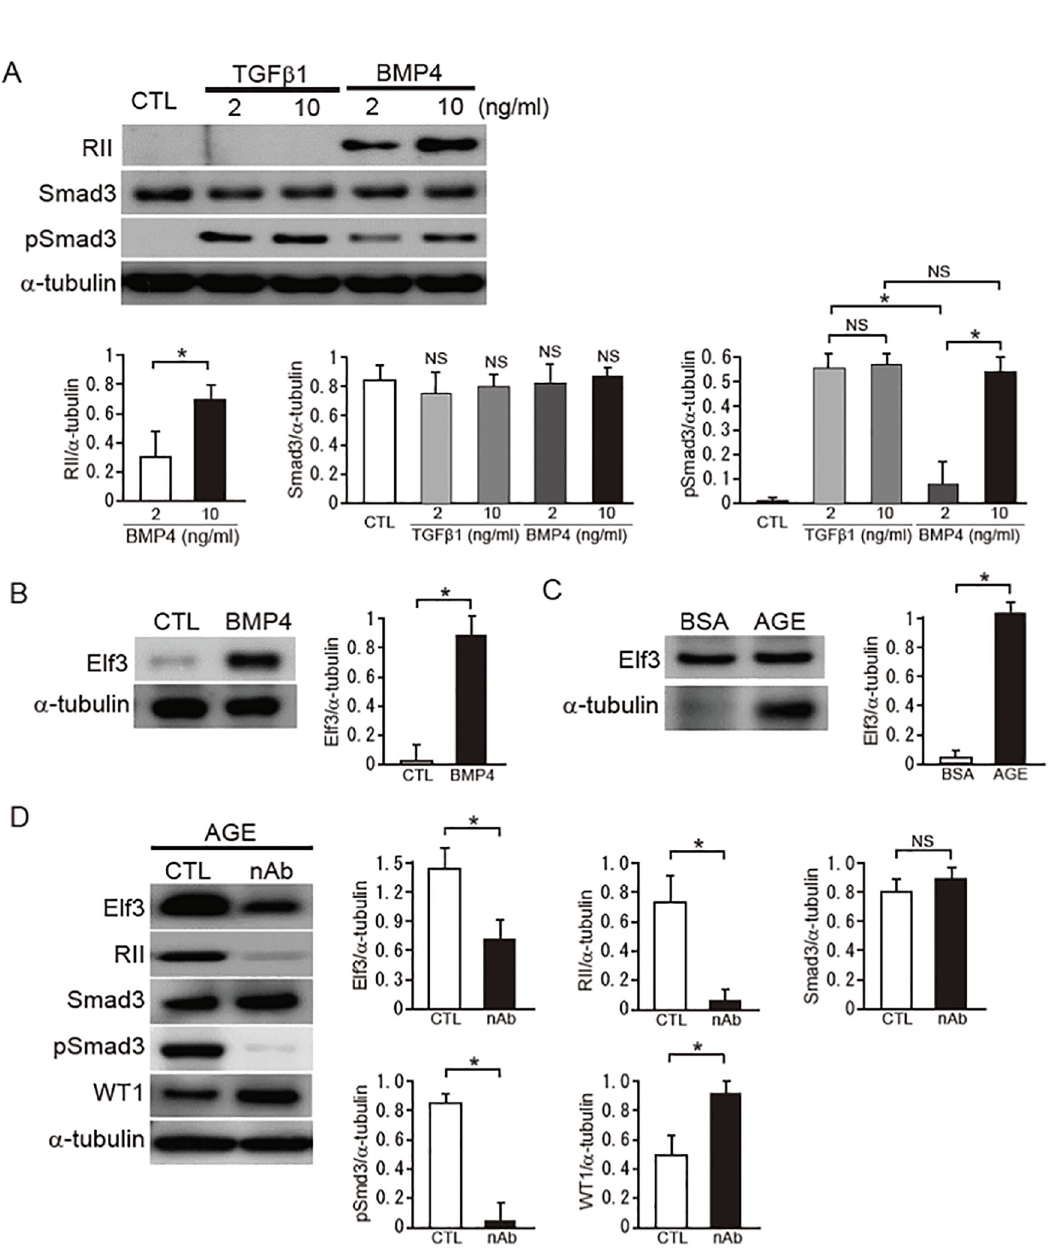
Fig 2. Induction of RII in podocytes via BMP4 in a diabetic condition. (A) Effects of TGF β 1 and BMP4 on the expression of RII and activation of Smad3 in cultured podocytes. (B) Effects of BMP4 on the expression of Elf3 in cultured podocytes. (C) Expression of Elf3 in cultured podocytes treated with AGE or BSA (5 μ g/ml) for 24 h. (D) Podocytes were treated with a neutralizing antibodies for BMP4 (nAb) (10 μ g/ml) or control normal IgG (CTL) for 24 h after a 24-h exposure to AGEs (5 μ g/ml). Equal amounts of cell lysates were subjected to western blotting. One of three independent experiments is shown. α -tubulin was used as loading control. Quantitation of these proteins expression was assessed by quantitative PCR analysis and normalized to the expression of α -tubulin.